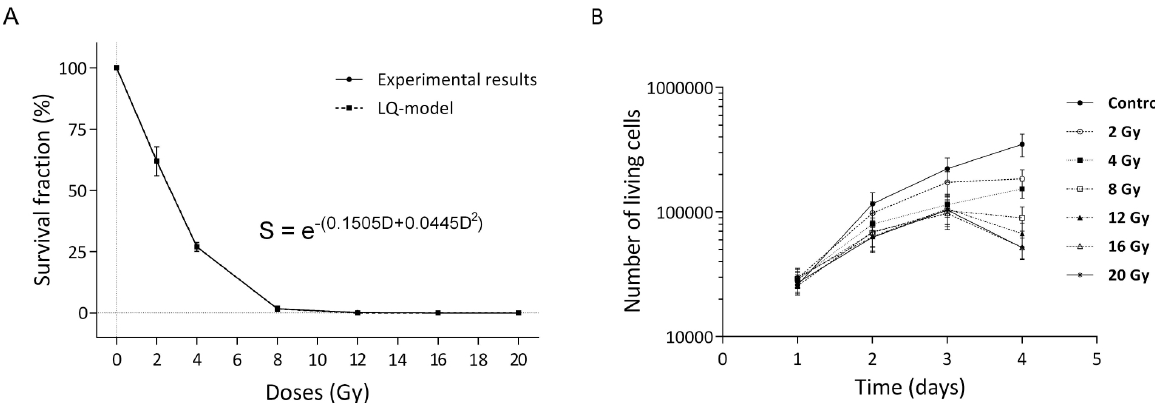
Figure 3. Clonogenic and proliferative capacities. a. Survival fraction based on the dose given (full line). Adjustment of the values to the LQ model (dotted line). b. Number of living cells as a function of time (days), for each dose delivered. Results are expressed as mean ±